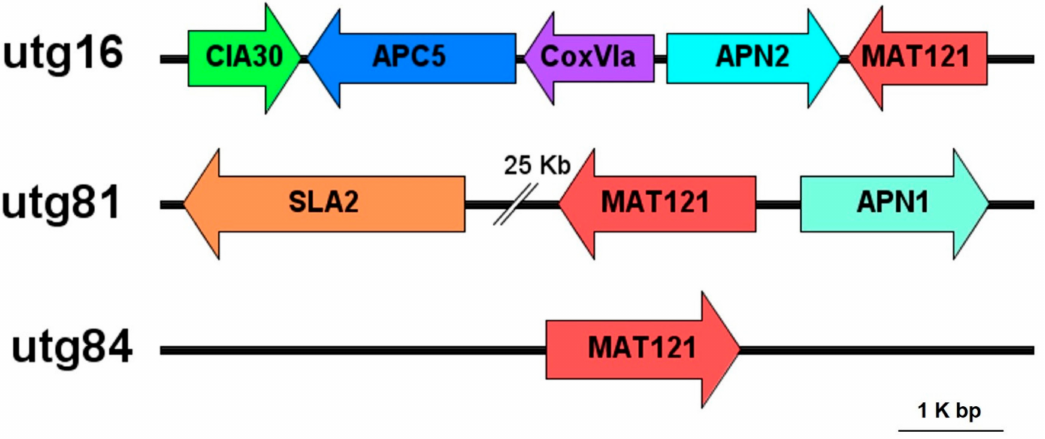
Figure 1. Organization of the mating-type loci (MAT) and flanking regions for in H. perniciosus HP10 genome. The arrows represent the orientation of the MAT1-2 genes APC5 (Anaphase-promoting complex subunit 5), APN1 (DNA lyase), APN2 (DNA lyase), CIA30 (Complex I intermediate-associated protein 30), CoxVIa (Cytochrome c oxidase subunit VIa) and SLA (cytoskeleton assembly